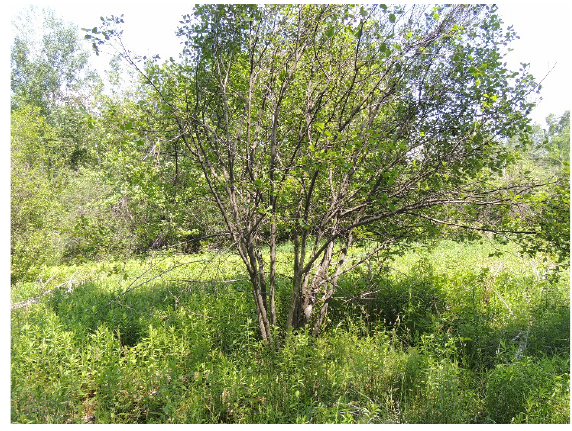
Figure 7 . Shrubby architecture of glossy buckthorns in open